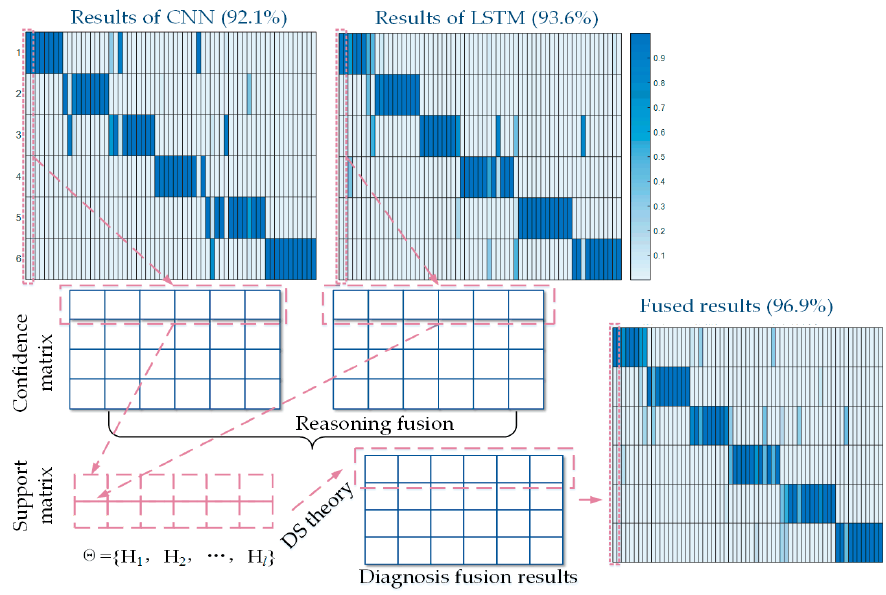
Figure 7. The schematic of deep parallel fusion (DPF).